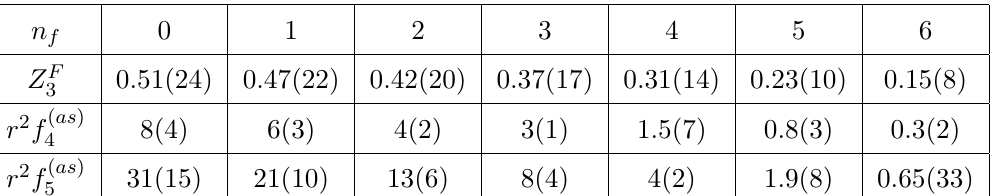
Table 1 . Normalization constant, Z F of (cid:13)avours n f in the MS scheme.